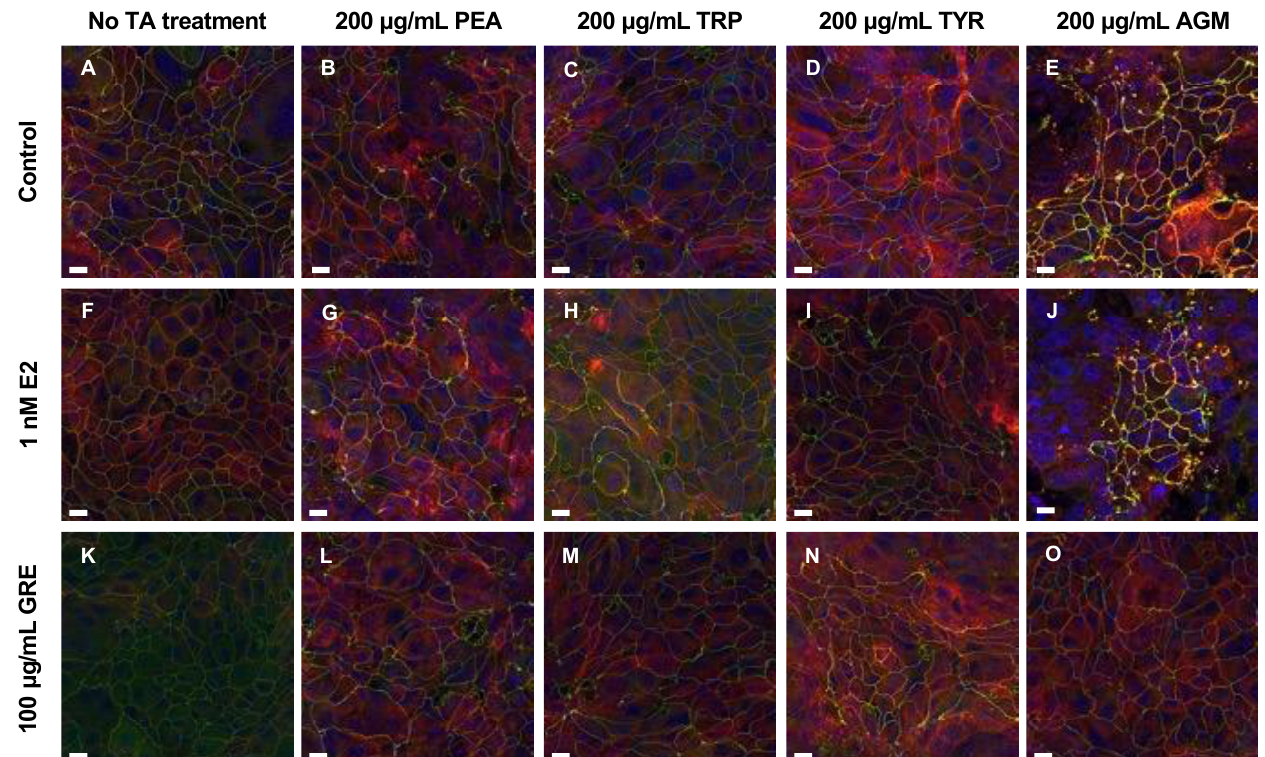
Figure 2. Representative fluorescent micrographs showing the effects of trace amines (TA, frames ( B – E )), green rooibos extract (GRE, frame ( F )), 17 β -estradiol (E2, frame ( K )) and combined treatments (frames ( G – J , L – O )) vs. control ( A ) on tight-junction proteins in HT-29 cell monolayers. Green signal = ZO-1, red signal = occludin, yellow signal = colocalized ZO-1 and occludin signal, and blue signal = Hoechst. All fluorescent images are maximum intensity projections of acquired z-stacks, imaged using the 60× oil immersion objective. Scale bar = 10 μ m. Abbreviations: PEA: β - phenethylamine, TRP: tryptamine, TYR: ρ -tyramine, AGM: agmatine.